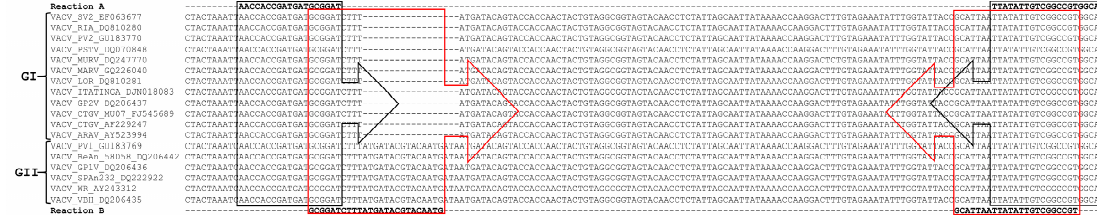
Figure 1. Alignment of the target DNA region within the A56R gene of the Vaccinia virus used for primer sequence design. The virus sequences were obtained from GenBank and the accession numbers are shown in the figure. The alignment was performed using the standard parameters of CLUSTAL W. The primers used in Reaction A ( A56R -gen F and A56R -gen R) are outlined in black and, for Reaction B ( A56R -BVV-nDEL F and A56R -generic R), are in red.